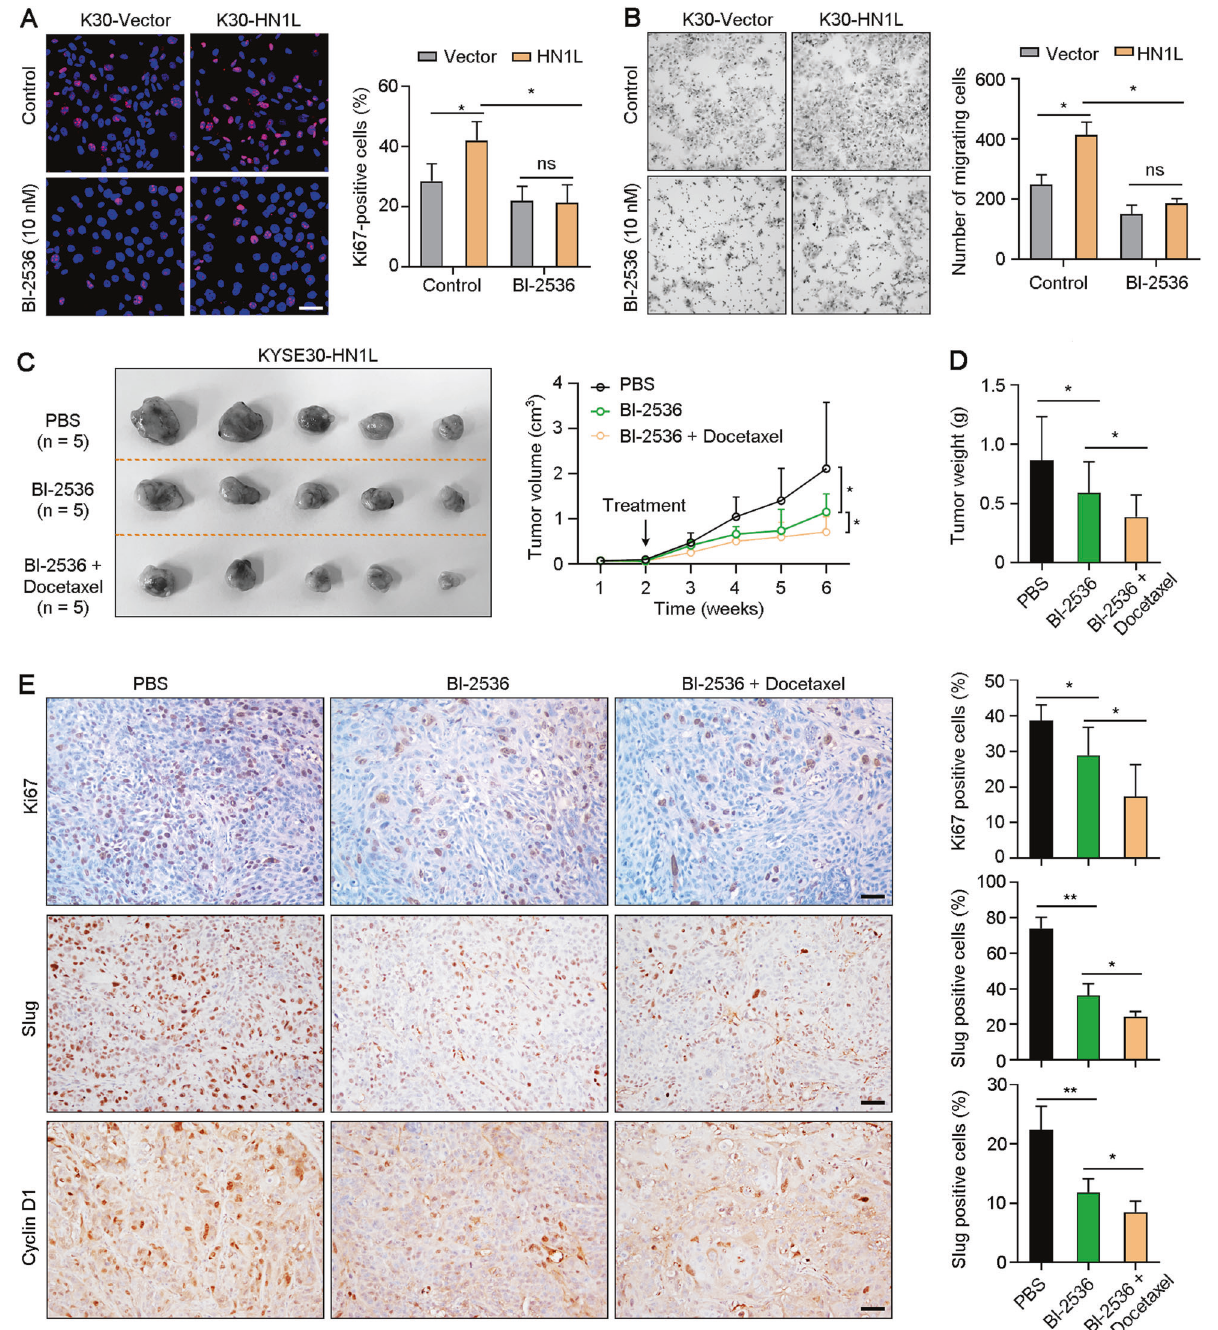
Fig. 7 Targeting PLK1 increases the sensitivity of ESCC cells to chemotherapy. A IF staining of Ki67 showed the cell proliferation rate of KYSE30-Vector and KYSE30- HN1L under treatment of PLK1 inhibitor BI-2536. Scale bar, 20 μ m. B Transwell migration assay was performed to test the cell migration ability of KYSE30-Vector and KYSE30- HN1L under treatment of BI-2536. C Xenograft tumors from KYSE30- HN1L cells were treated with BI-2536 (5 mg/kg) and Docetaxel (3 mg/kg) 2 weeks after cell injection. Medication was given twice a week for 2 weeks. Tumor volumes ( C ) and weights ( D ) were counted. E IHC staining with antibodies against Ki67, Slug, and Cyclin D1 was performed on xenograft tumors. Scale bar, 50 μ m. In all panels, data are presented as the mean ± SD; two-sided Student ’ s t test; * P < 0.05, ** P < 0.01, ns: no signi fi cant